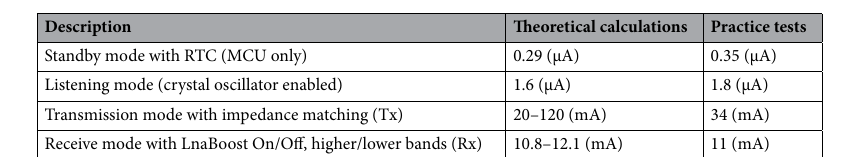
Table 4. Compare the energy consumption of LoRa module according to theoretical calculations and practice